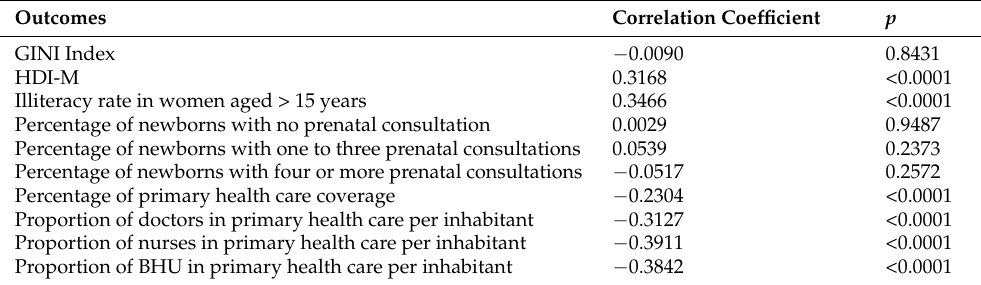
Table 3. Correlations between gestational syphilis detection rate and socioeconomic and health care